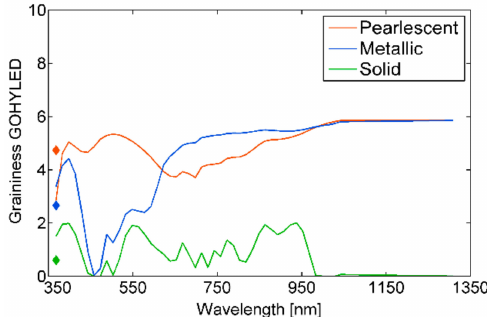
Figure 9. GOHYLED graininess spectra of a pearlescent (orange), a metallic (blue) and a solid (green) sample for the geometry of d: 12.5 ◦ . The graininess value corresponding to the white LED cluster is represented in each graph with a diamond marker.